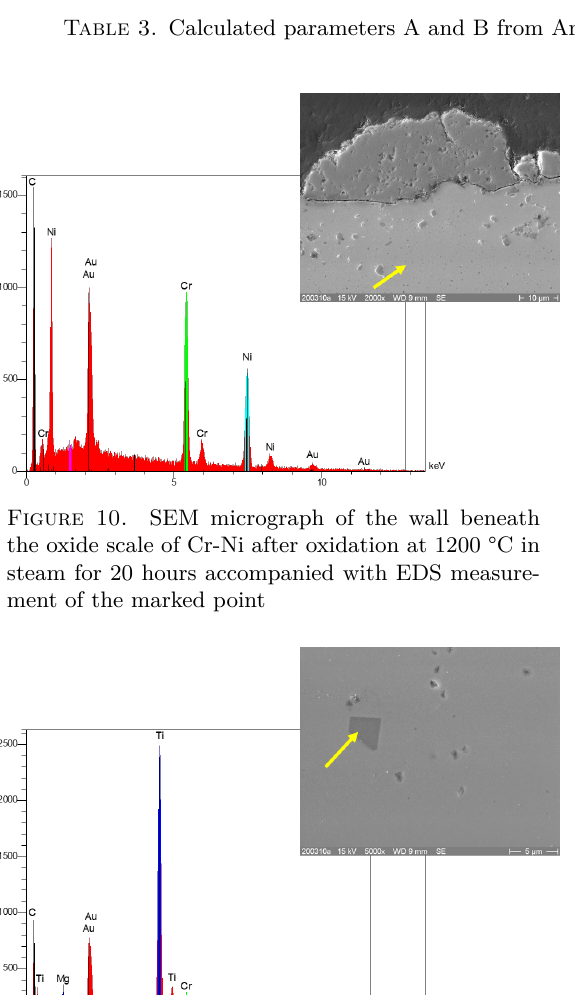
that the correlation for Cr-Ni alloy is not highly ac- curate, given that its kinetics does not correspond to the parabolic law, see Table 2.